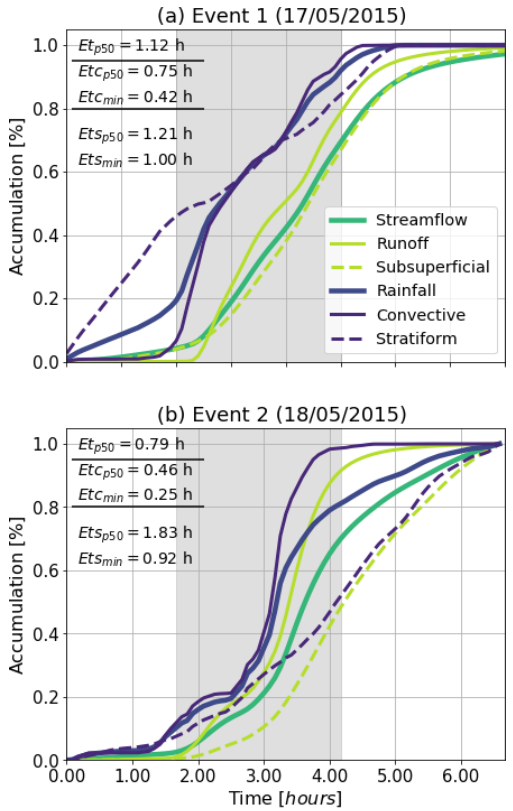
Figure 14. Accumulated rainfall and streamflow for (a) Event 1 and (b) Event 2. The accumulation is expressed in percentage with respect to the total value in each case. The median elapsed time and minimum elapsed time are estimated between total (Et p50 , Et min ), convective (Etc p50 , Etc min ), and stratiform (Ets p50 , Ets min ) rainfall and the runoff portion of the streamflow. Gray bands correspond to the periods for elapsed time estimation.